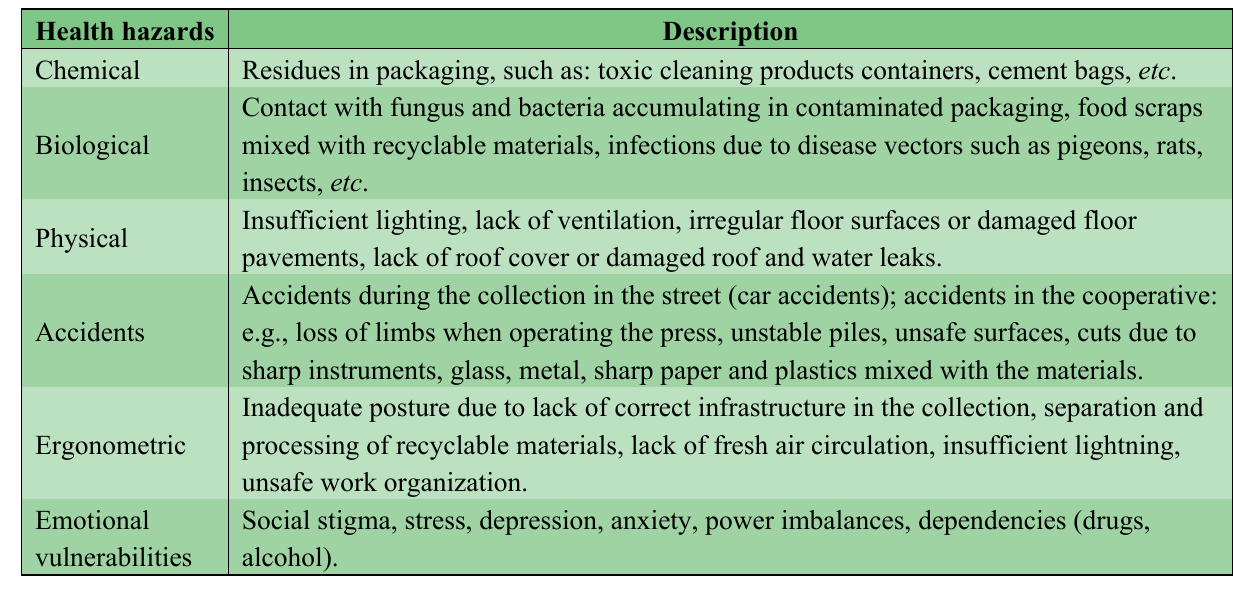
Table 1. Key health hazards and risks identified during the